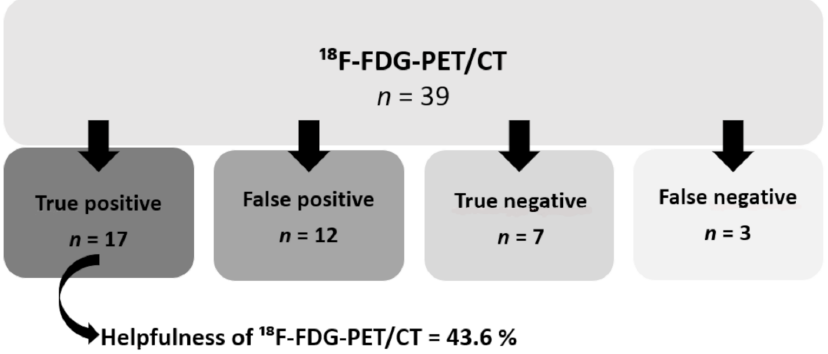
Figure 3. Diagnostic contribution of 18